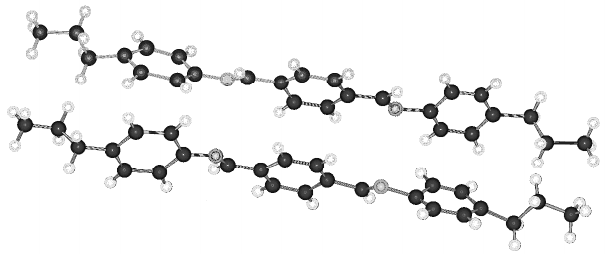
Figure 27. Conformation of TBAA-3 in space group P2 with two independent molecules, representing actually distorted symmetry related molecules in the centrosymmetric space group